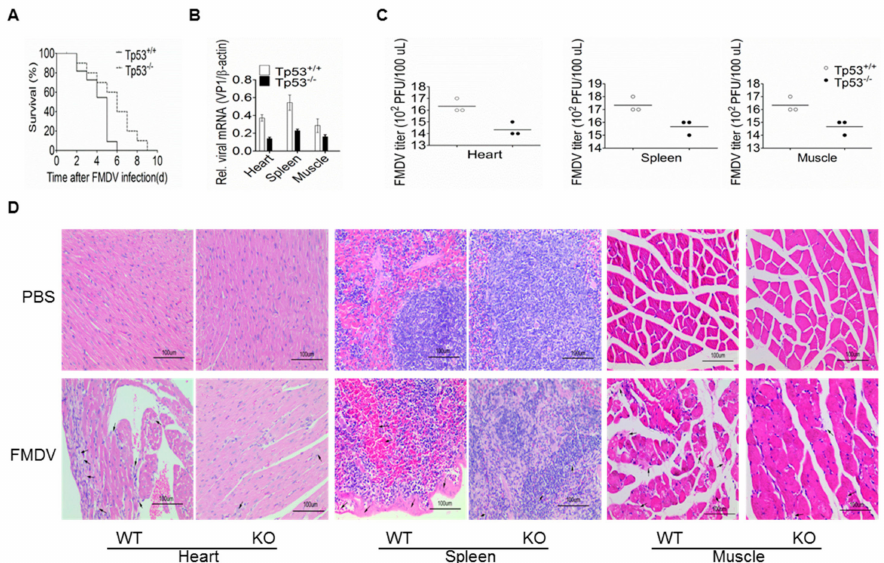
Figure 5. E ff ects of p53 knockout on FMDV replication and pathogenicity in mice. ( A ) FMDV-induced death was delayed in p53-KO mice. Four-week-old WT and p53-KO mice were intraperitoneally injected with FMDV (100 LD 50 ), and the survival rate was calculated each day. The experiment was repeated twice and a similar result was obtained. n = 10 for each experiment. ( B ) FMDV RNA was reduced in the hearts, spleens and muscles of p53-KO mice. The adult mice were challenged with FMDV using the same method as described in (A). Mice were euthanized at 3 days post-infection (dpi) and their hearts, spleens, and thigh muscles were sampled for RNA extraction. RT-qPCR was performed to quantify the relative level of VP1 mRNA. The experiment was performed in triplicates and the bars are SD. ( C ) FMDV titer was reduced in the hearts, spleens, and muscles of p53-KO mice. Samples were collected the same as in (B), and the virus titer was determined using TCID 50 method. n = 3. The lines represent average values. ( D ) Histopathological changes in the hearts, spleens, and muscles of p53-KO mice were alleviated. Samples were collected the same as in (B) and were immediately fixed with 4% paraformaldehyde solution for further sectioning and hematoxylin and eosin (HE) staining. Note the black arrows indicate abnormal histopathological changes. Three biological replicates were taken for each treatment group and the representative images were shown. Bars = 100 µ